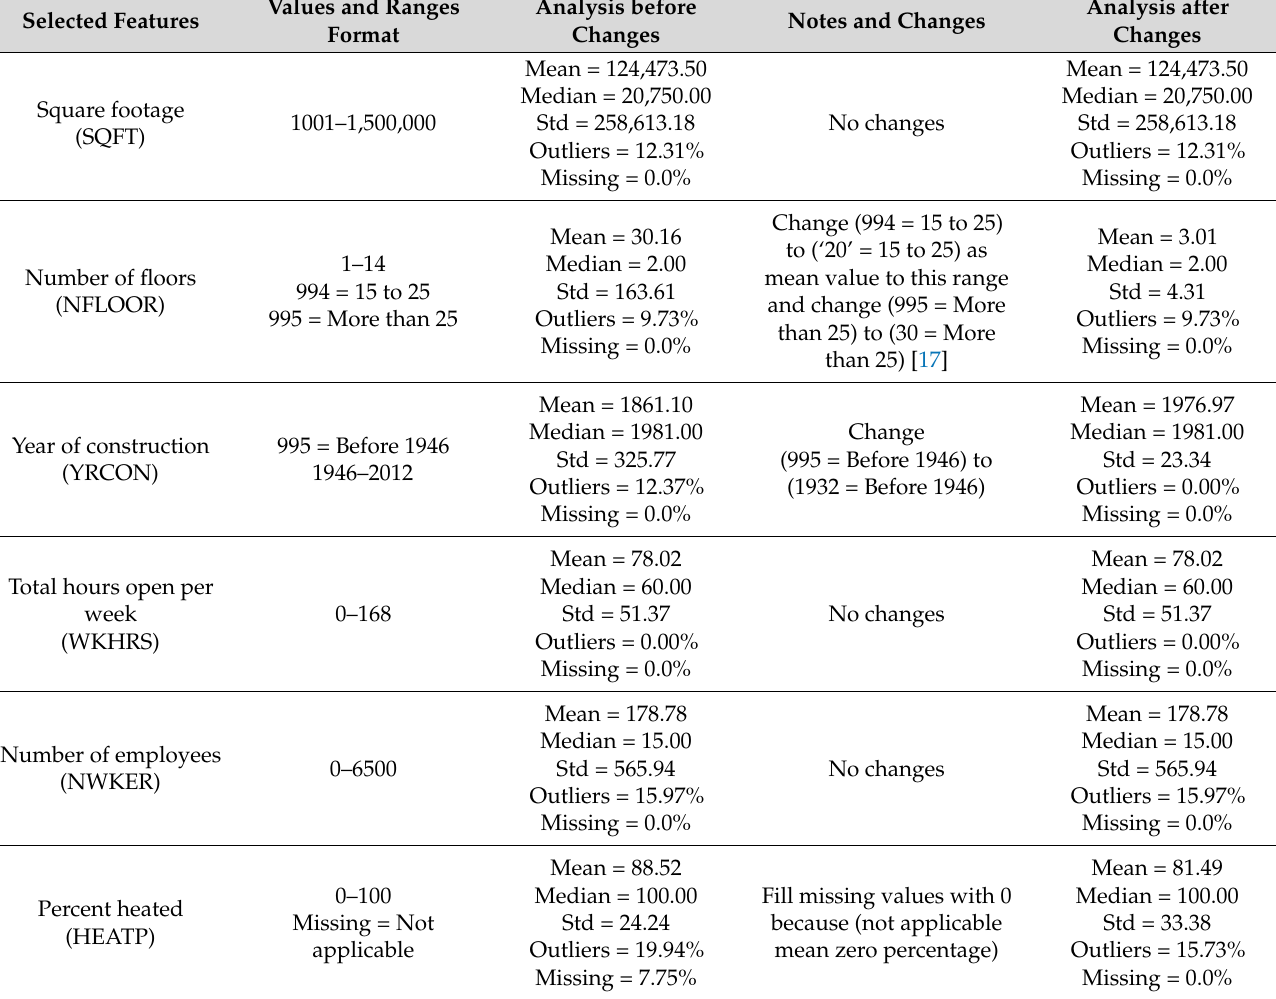
Table 3. Selected features’